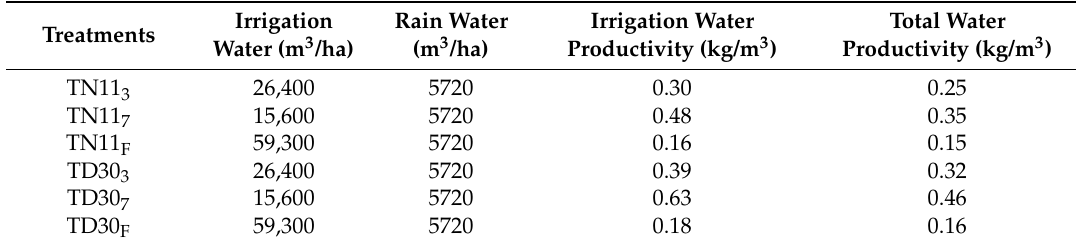
Table 5. Effects of irrigation regimes on water